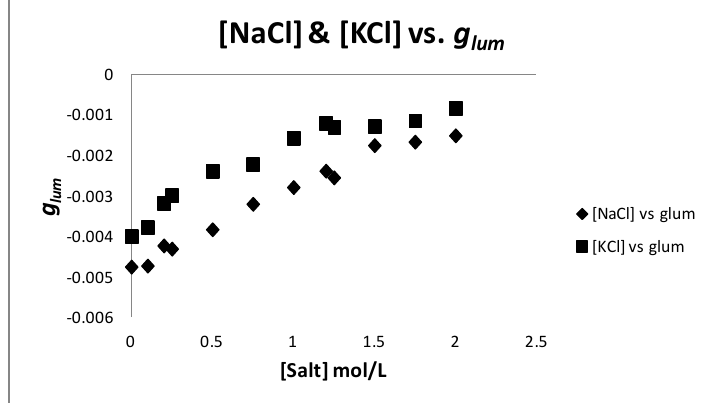
Figure 11. Plot of luminescence dissymmetry values ( g lum ) of [Tb(DPA) 3 ] 3− . Conditions: 0.005 M [Tb(DPA) 3 ] 3− with 40 equiv. L -serine and [NaCl] (bottom line triangles, R 2 = 0.9019 or [KCl] (top line circles, R 2 = 0.9774) varied from 0 to 2.0 M, monitored at the spectral range of 5 D 4 → 7 F 5 at room temperature and pH 6.6, and measured at λ ex = 283.00–289.00 nm and λ em = 542.80–543.00 nm. Without NaCl, or rather, at a salt concentration of zero, the amino acid is free to interact with